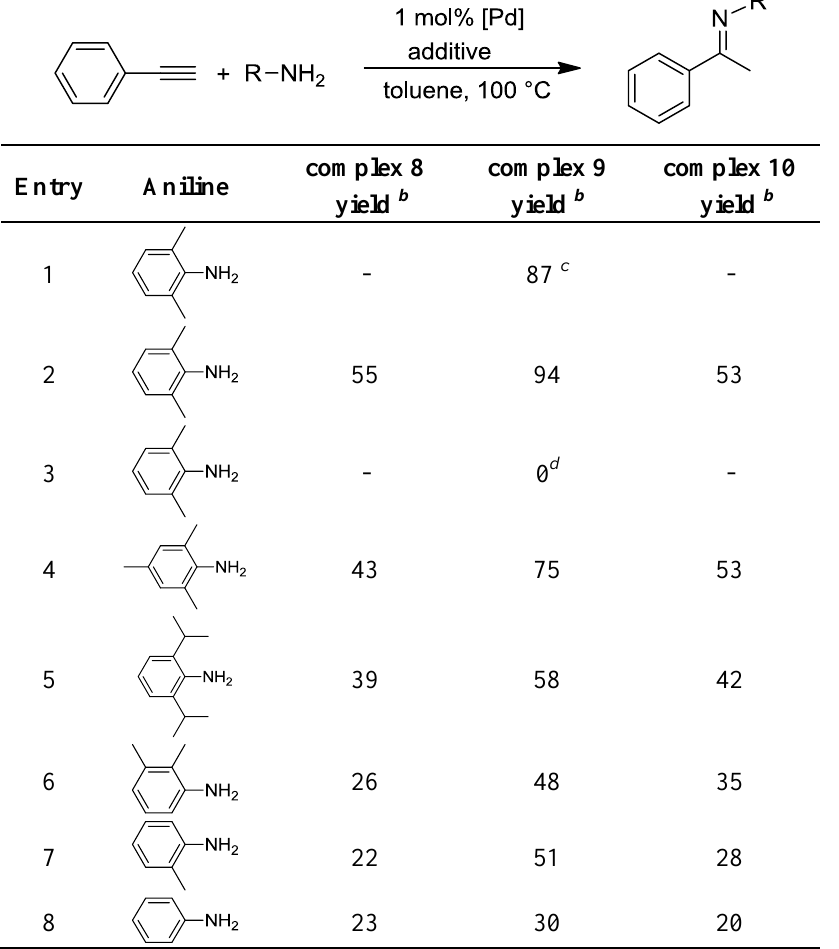
Table 4. Hydroamination reactions a catalyzed by complexes 8 – 10